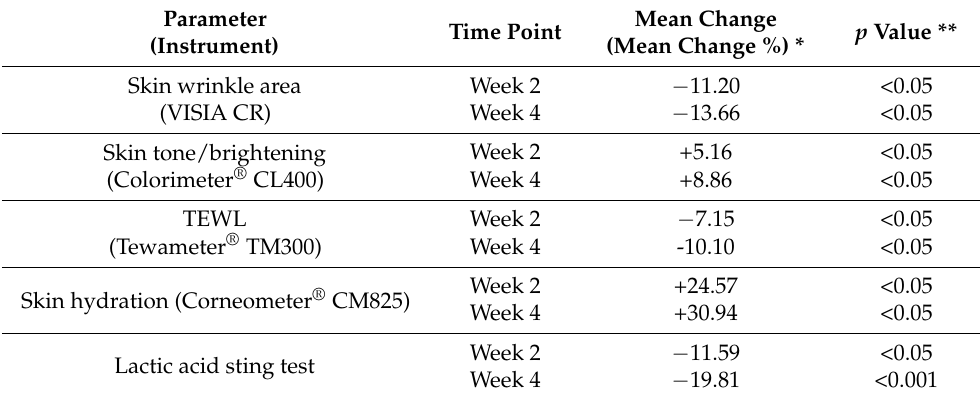
Table 5. Summary of clinical endpoints *.